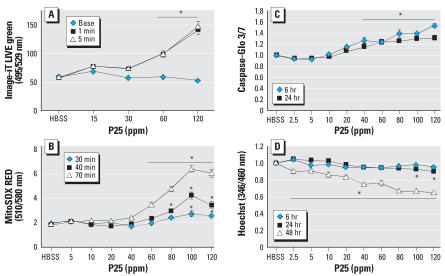
(A) The immediate production of intracellular H2O2 generated from the oxidative burst was measured in BV2 microglia with Image-iT LIVE Green. Cells were incubated (30 min, 37°C) in 25 μM Image-iT LIVE Green and exposed to P25. Significant increases of fluorescence first occurred in response to P25 (60 ppm; 1 min). (B) The production of
 resulting from interference with the mitochondria’s ETC was measured with MitoSOX Red. BV2 microglia, incubated in 2 μM (10 min, 37°C) showed a delayed but significant increase in fluorescence after 30-min exposure to ≥100 ppm P25. (C) Significant increases of caspase 3/7 activity were first seen by 6 hr in response to ≥40 ppm P25 and remained at this level for 24 hr. (D) Apoptotic loss of nuclear material, as measured with Hoechst stain, was first noted after 24 hr in response to P25 (≥100 ppm) and involved all concentrations by 48 hr.